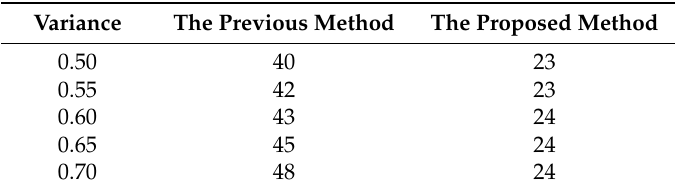
Table 7. Comparison of fluctuation result for energy supply and demand.